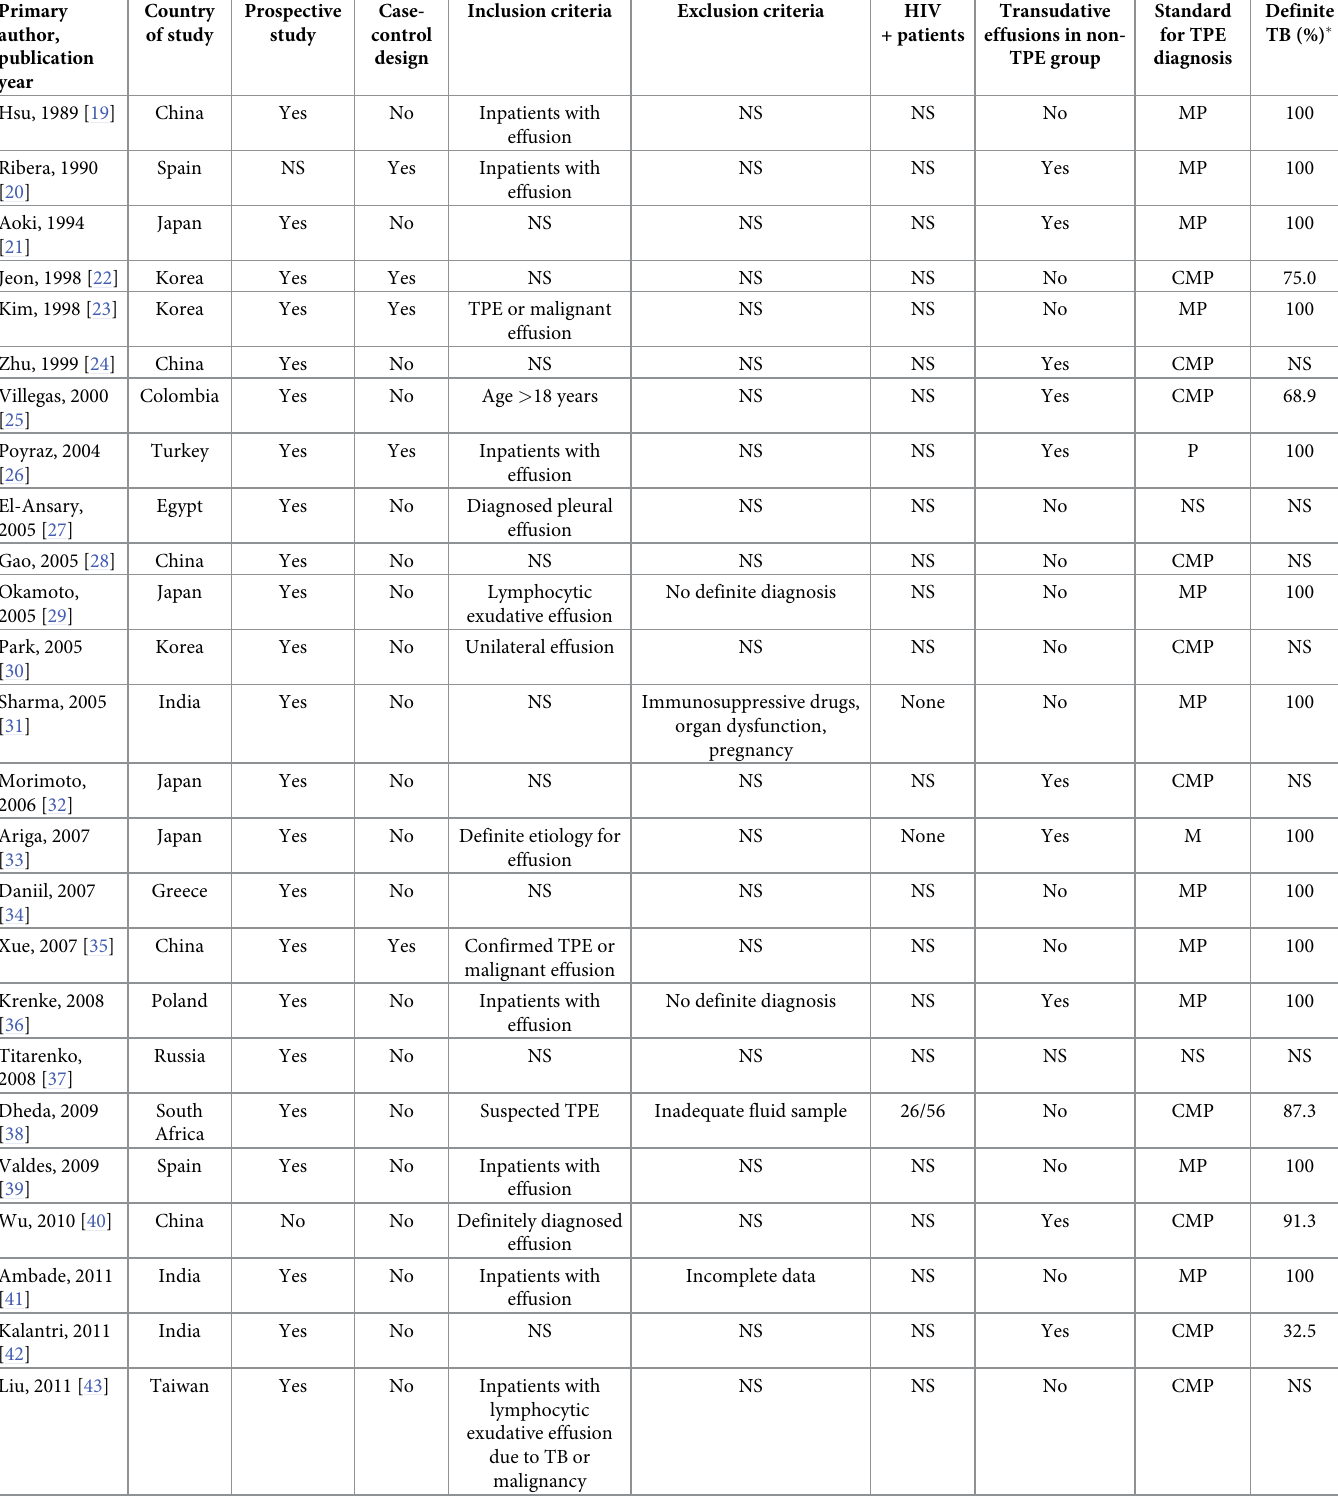
Table 1. Characteristics of studies included in data